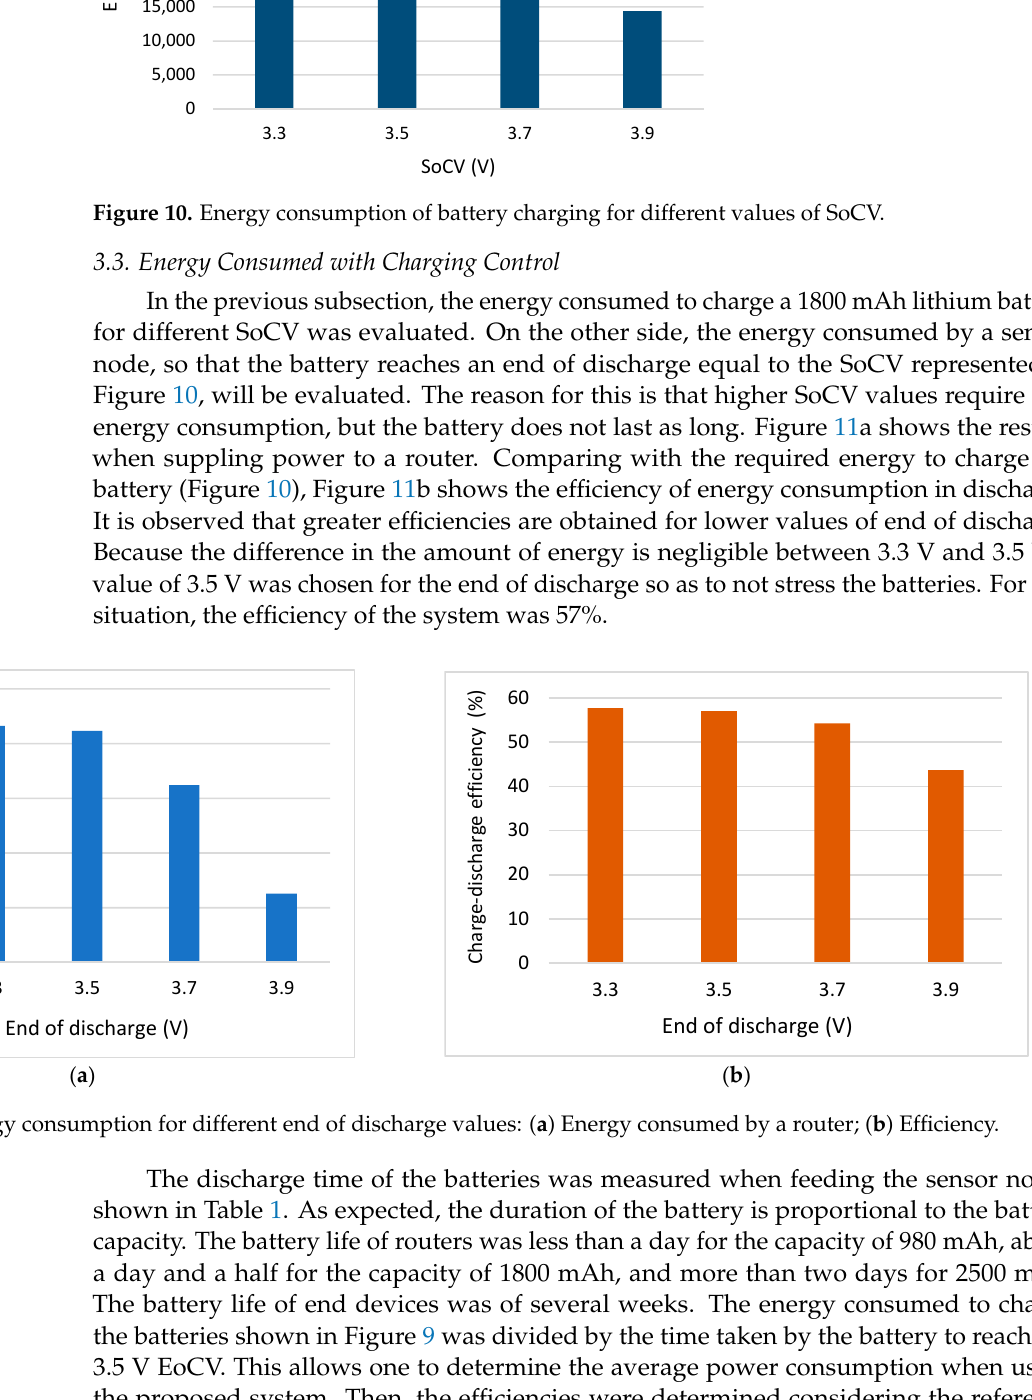
Figure 9. Energy consumption for charging batteries of different capacities and for two sources of energy.